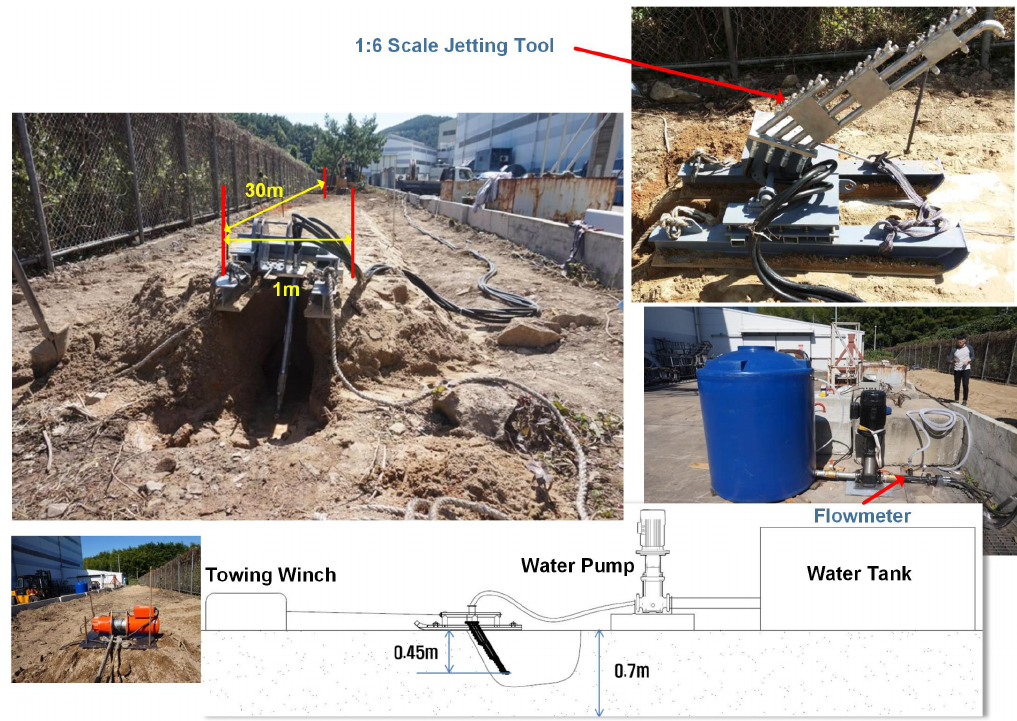
Figure 11. Ground field test